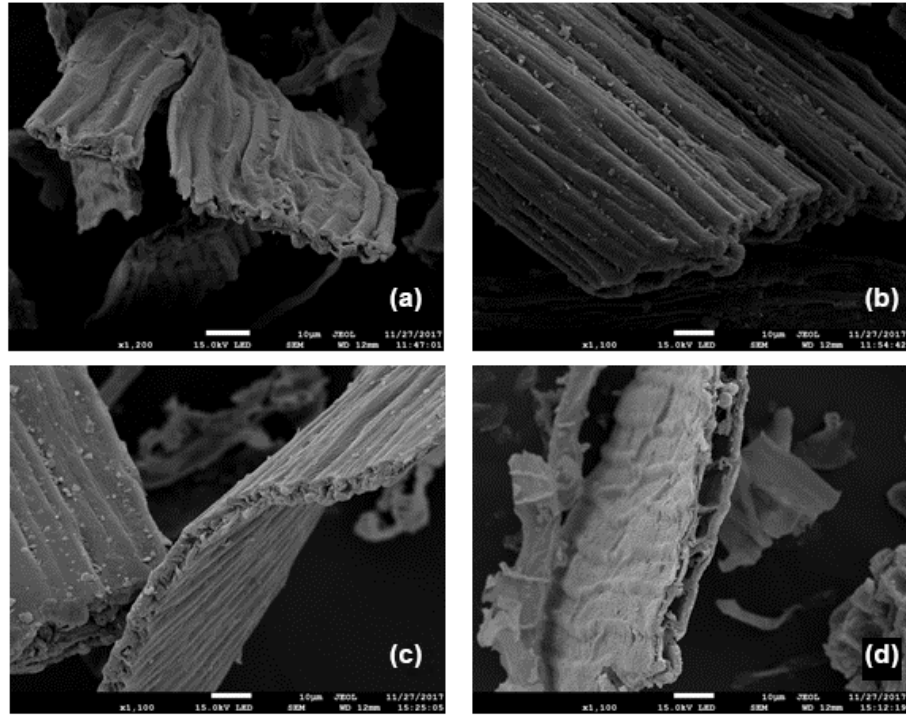
Figure 7. Representative scanning electron micrographs of moss tissues before (a, c) and after (b, d) incubation. Panels (a) and (b) depict mosses from the cooler forest, and the panels (c) and (d) depict mosses from the warmer